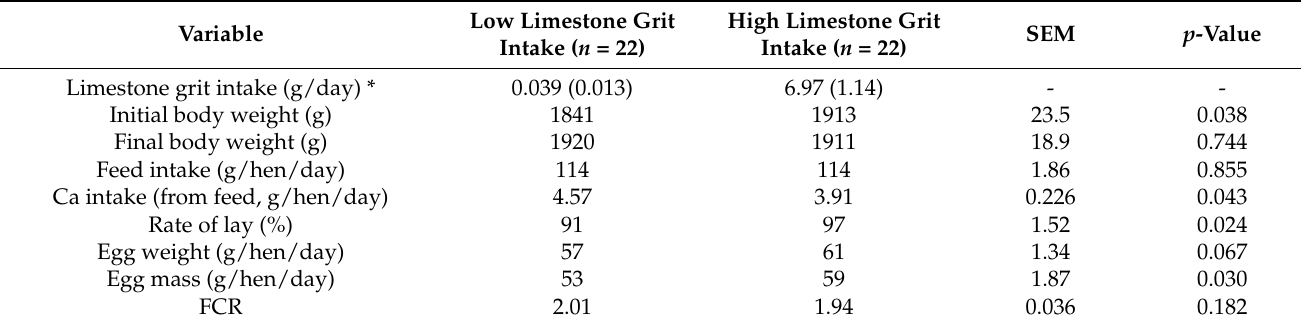
Table 4. Comparison of the performance data of the extreme 15% of hens ranked as high or low on limestone grit intake, regardless the treatment